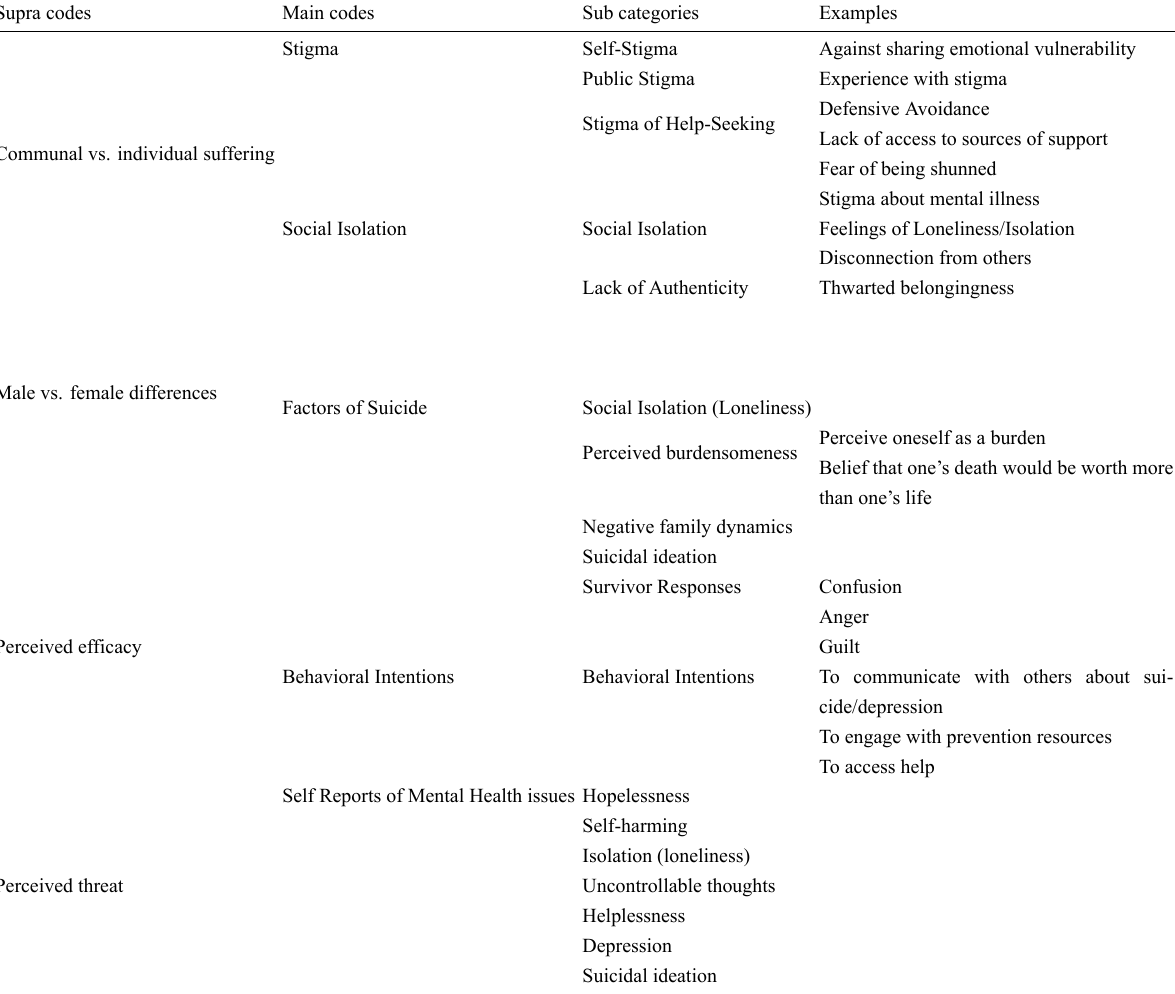
Table 7. A priori coding categories, sub-categories and descriptive